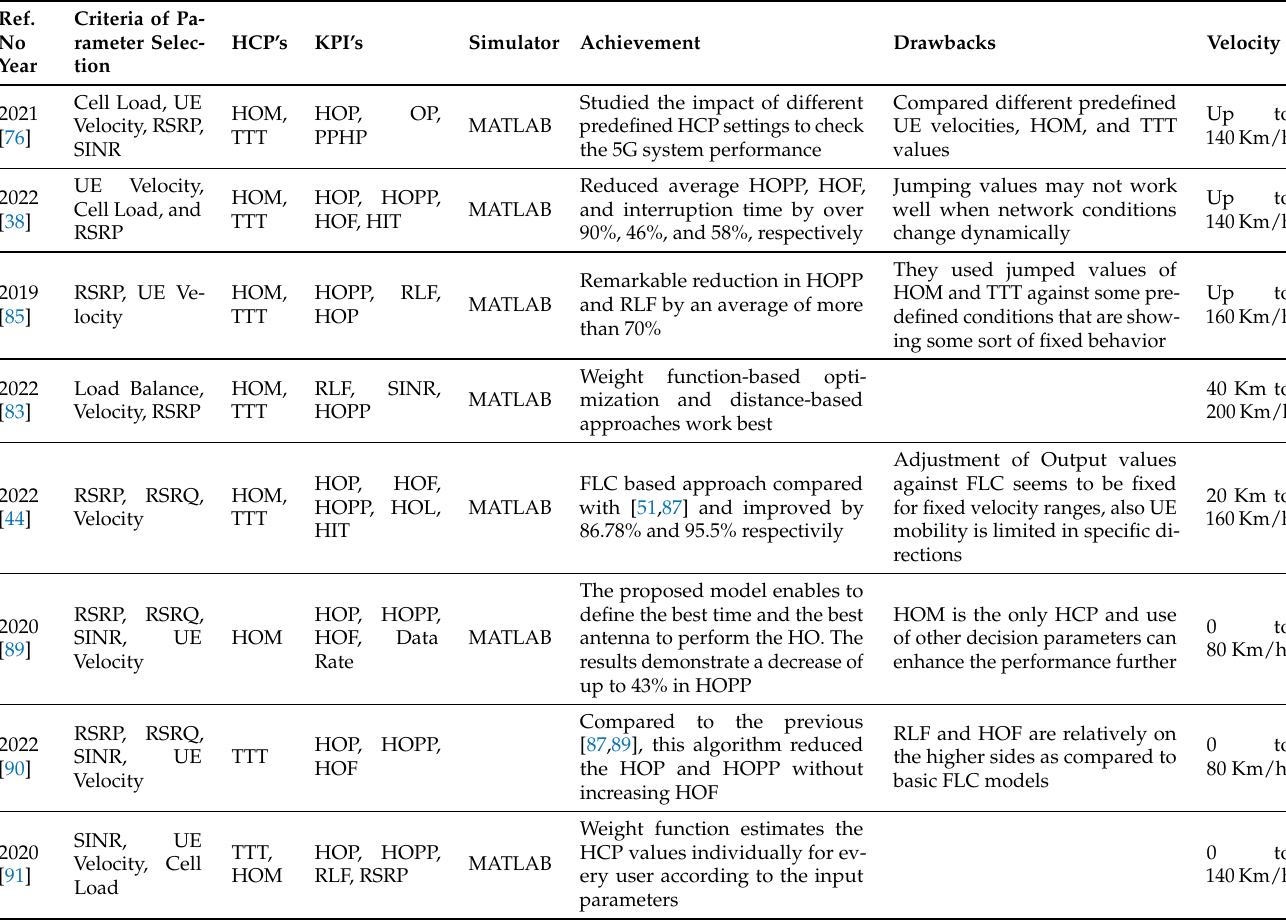
Table 5. Summary of Velocity-based Handover